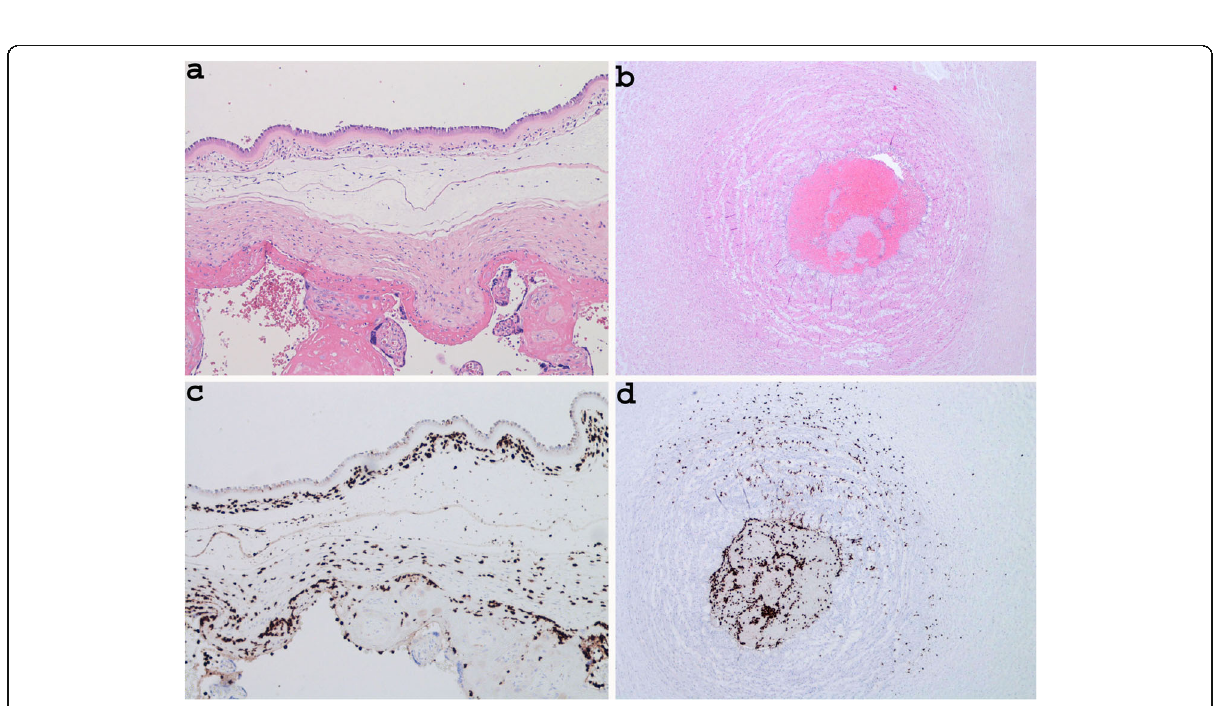
Fig. 3 Histological section showing chorioamnionitis with patches of neutrophil granulocytes in the context of connective tissue located below the amniotic epithelium ( a Case 2, haematoxylin and eosin stain × 200); indecipherable umbilical arteritis on haematoxylin and eosin stain in the same case ( b haematoxylin and eosin stain × 40), the same sections on immunohistochemical analysis showing positivity for CD15 in the amniotic membrane ( c × 100) and in smooth muscle of one umbilical artery and Wharton ’ s jelly ( d ×